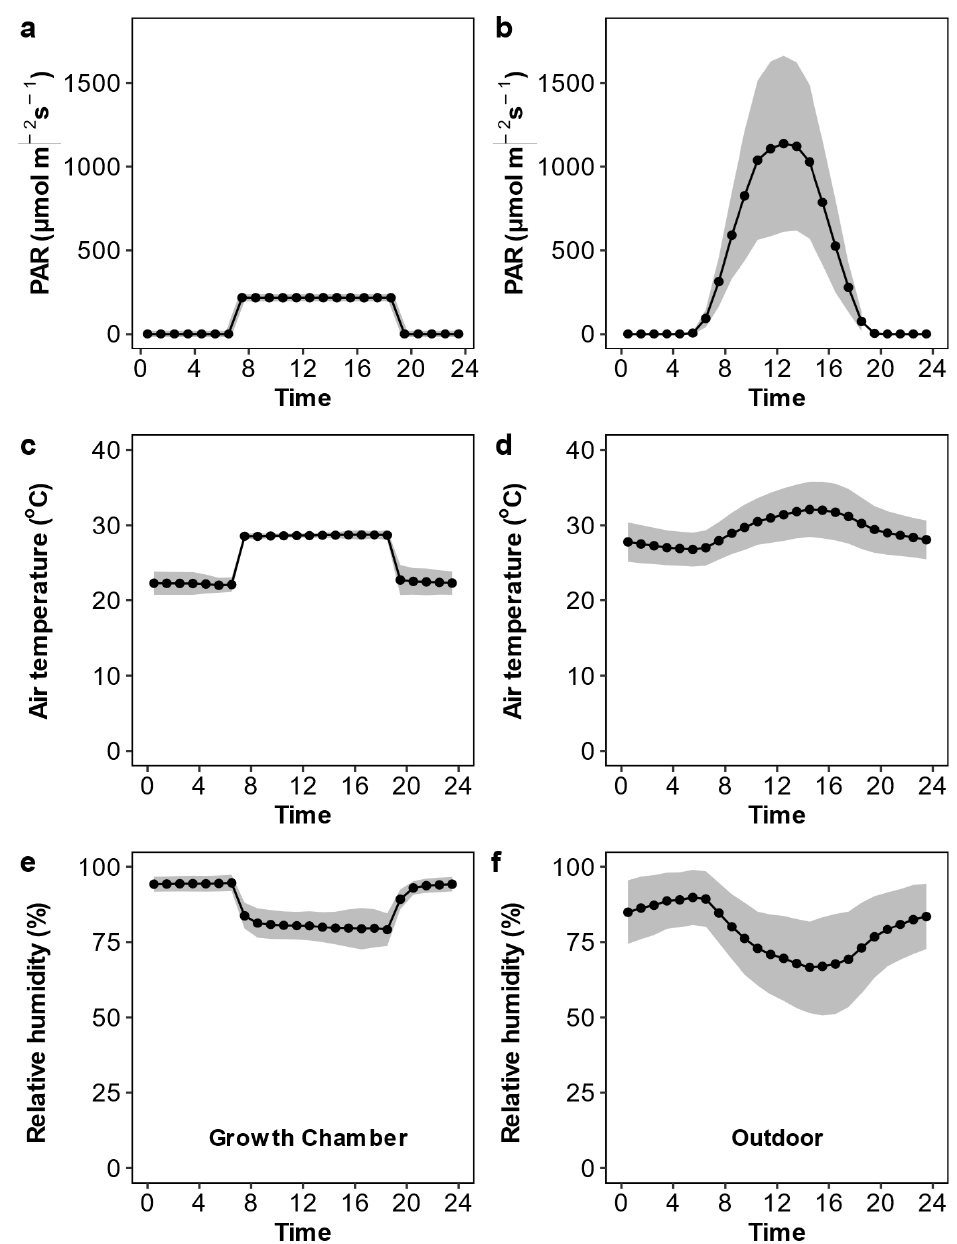
Figure 1. Photosynthetic active radiation (PAR; a , b ), air temperature ( c , d ), and relative humidity ( e , f ) inside the growth chamber ( a , c , e ) and outdoors ( b , d , f ). The black points and lines are the mean values over the growth duration, and grey shaded areas are the 95% confidence interval. Table 1. Leaf traits for five Oryza species, with expected plastic and adaptive responses to growth conditions (outdoors and in the growth chamber), and results of the ANOVA testing the effects of